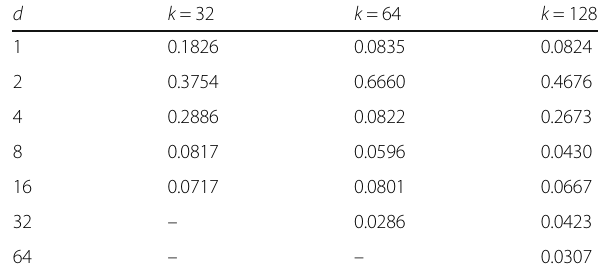
Table 8 Optimal degree distributions obtained from